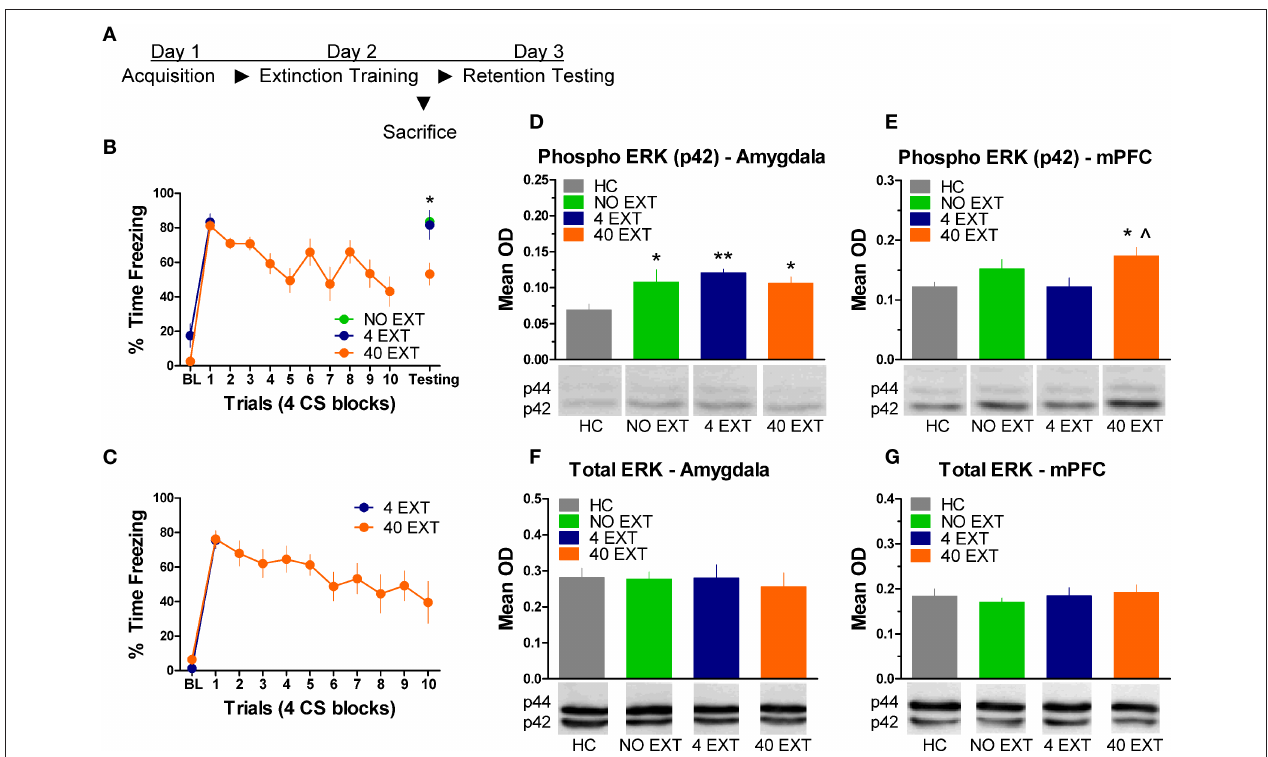
given no extinction ( N = 8, green), 4 trials of extinction ( N = 7, blue) or 40 trials of extinction ( N = 9, orange) compared to home cage rats ( N = 8, gray). Levels of total ERK in the amygdala (F) and mPFC (g) in the same set of rats. The graphs show mean optical density (OD) values ( ± SEM) for each treatment group (* p < 0.05 relative to HC; ** p < 0.01 relative to HC; ^ p < 0.05 relative to 4